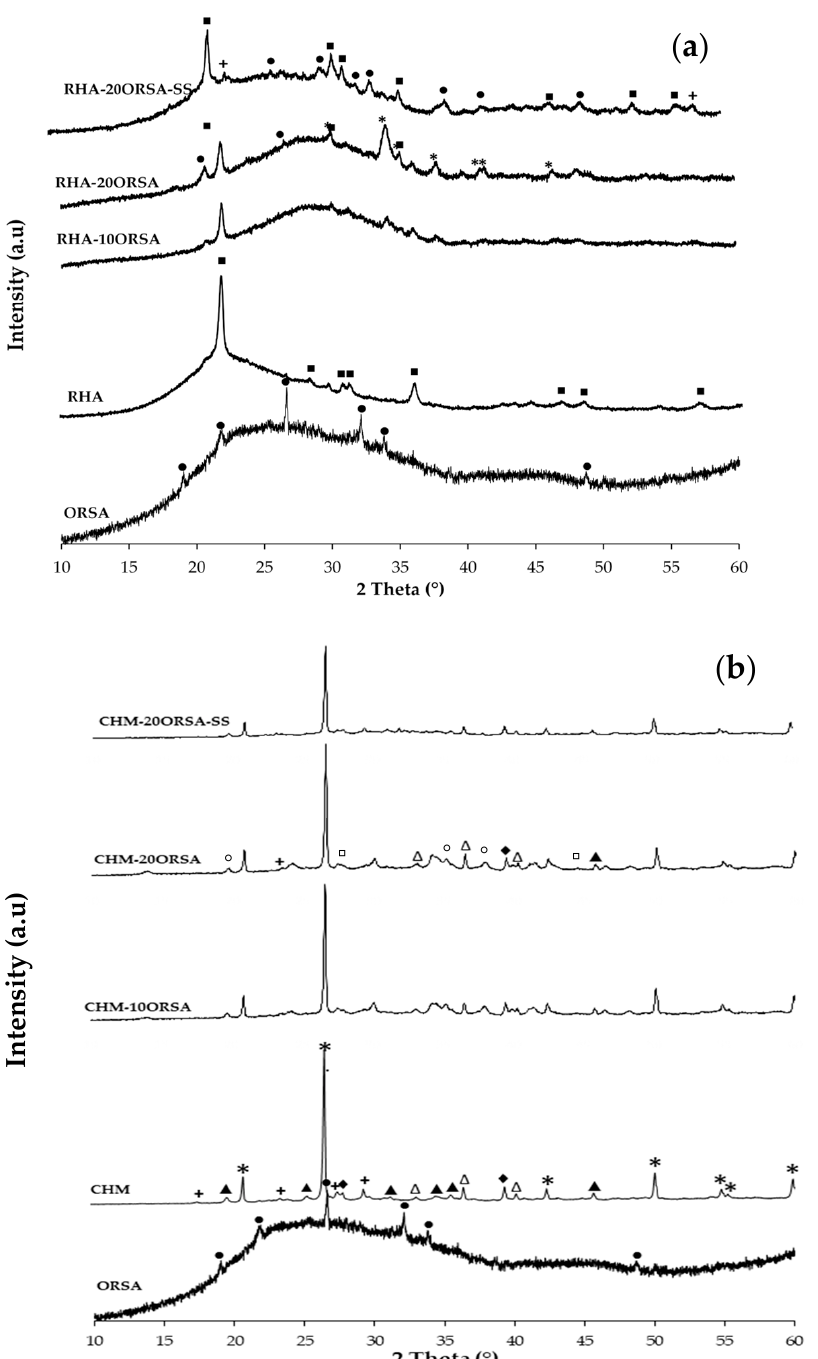
Figure 7. XRD patterns of ( a ) RHA-xORSA geopolymers (+: quartz; * Na 2 (CO 3 ); ■ : cristobalite; ● : AlPO 4 ) and ( b ) CHM-xORSA geopolymers (*: quartz; ∆ : hematite; +: nephelite; ▲ : illite; ♦ : albite; ● : AlPO 4 ; ◦ Na 2 (CO 3 ); ▫ :CaCO 3 .